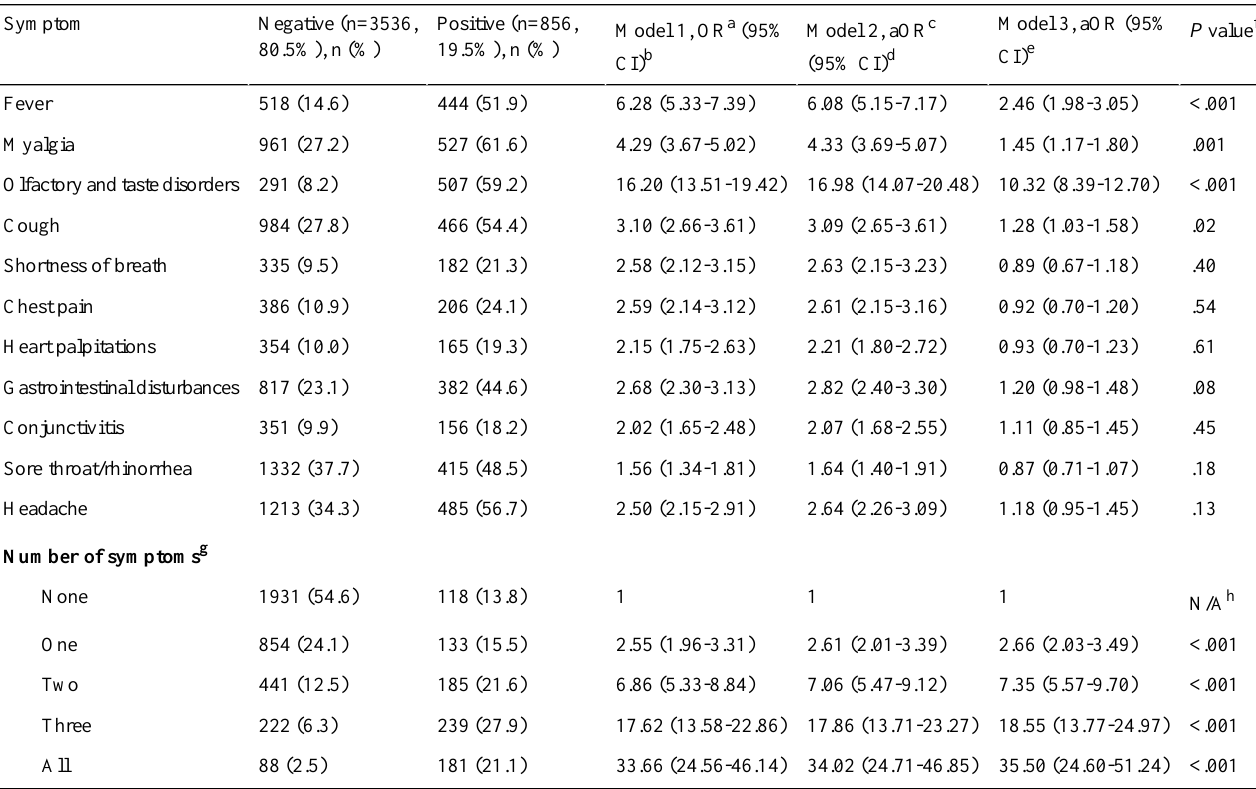
Table 3. Odds ratios of positive molecular tests in nonhospitalized respondents with known molecular test results (n=4392, subsample